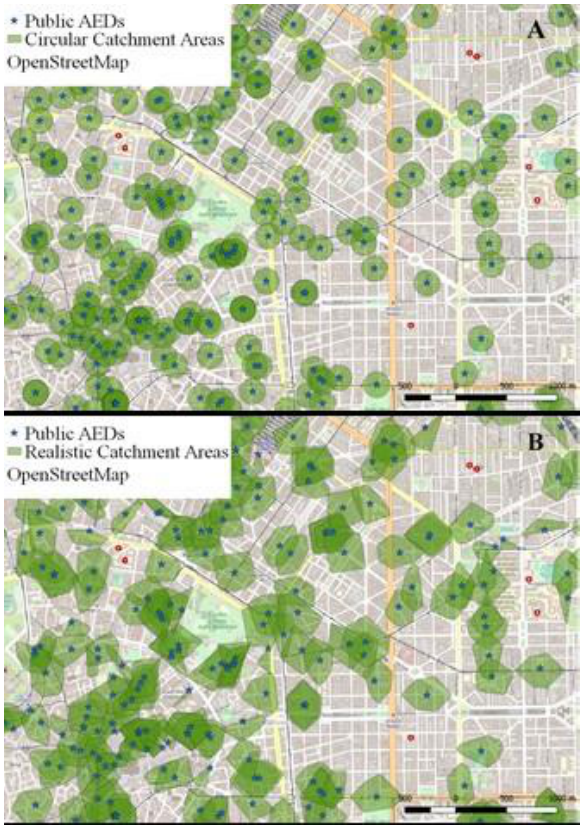
Figure 1. Mapping of catchment areas for AEDs in a portion of the city of Milan (Lombardy, Italy), with circular (panel A) and realistic (panel B)